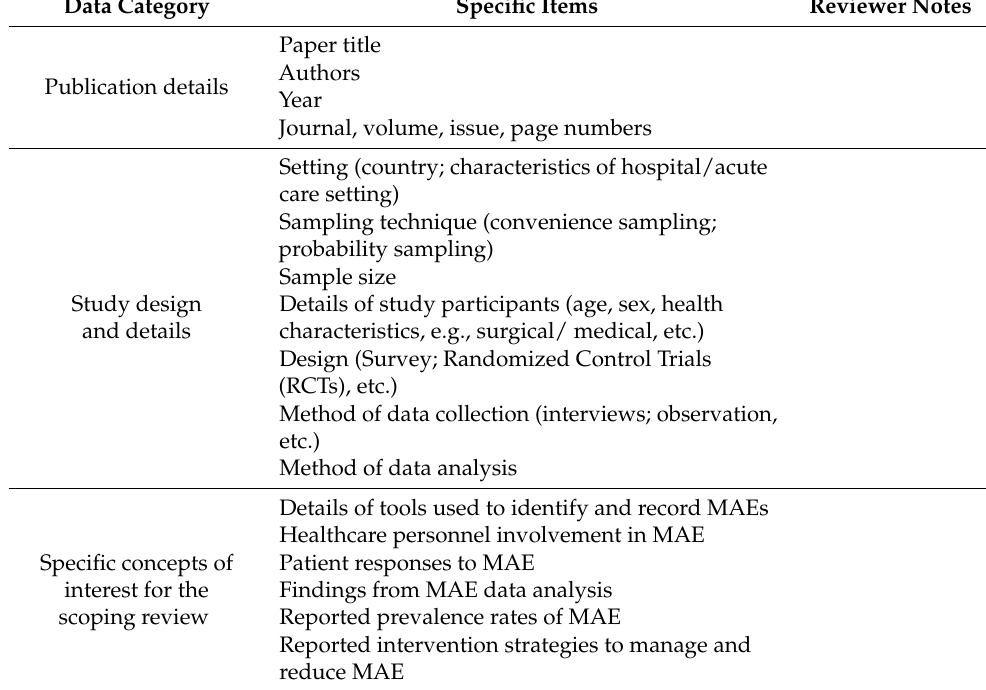
Table A2. Data Extraction Tool for Published/Peer Reviewed Literature.